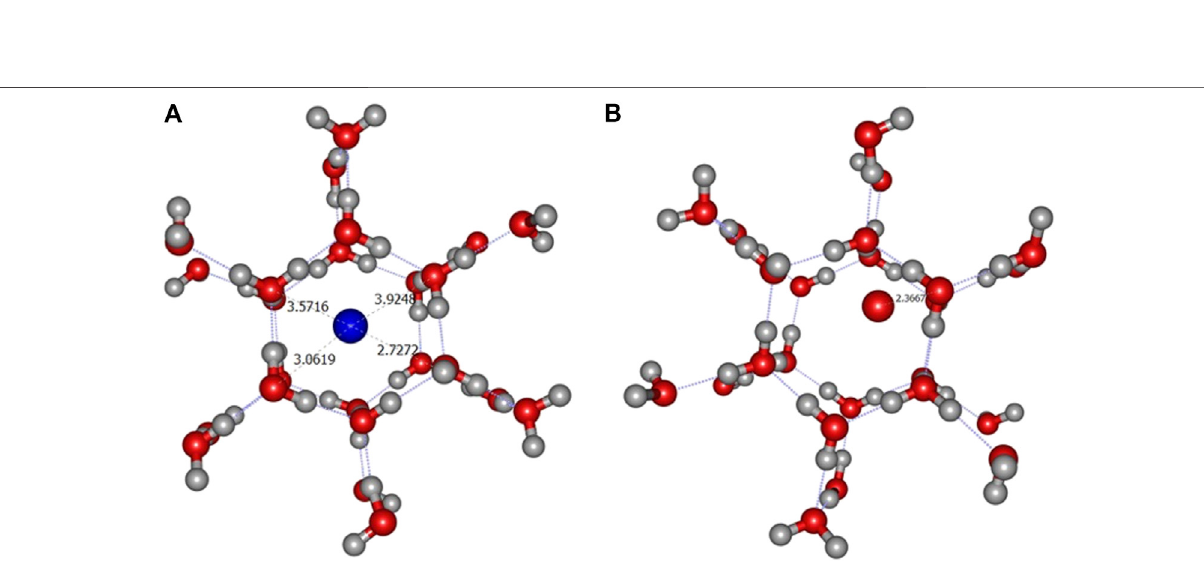
Frontiers in Astronomy and Space Sciences |